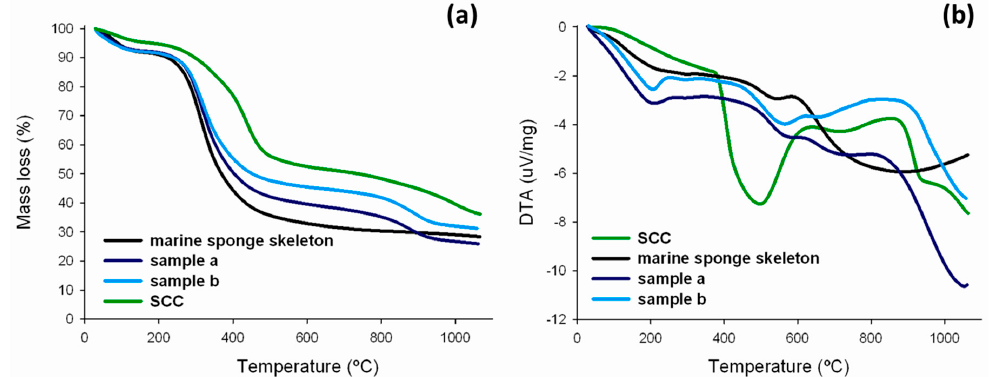
Figure 8. TG ( a ) and DTA ( b ) curves for H. communis sponge skeletons, SCC, and selected samples (sample a: 400 mg/L, sampleb: 750 mg/L; 30 min; pH neutral; 0.1 M NaCl).